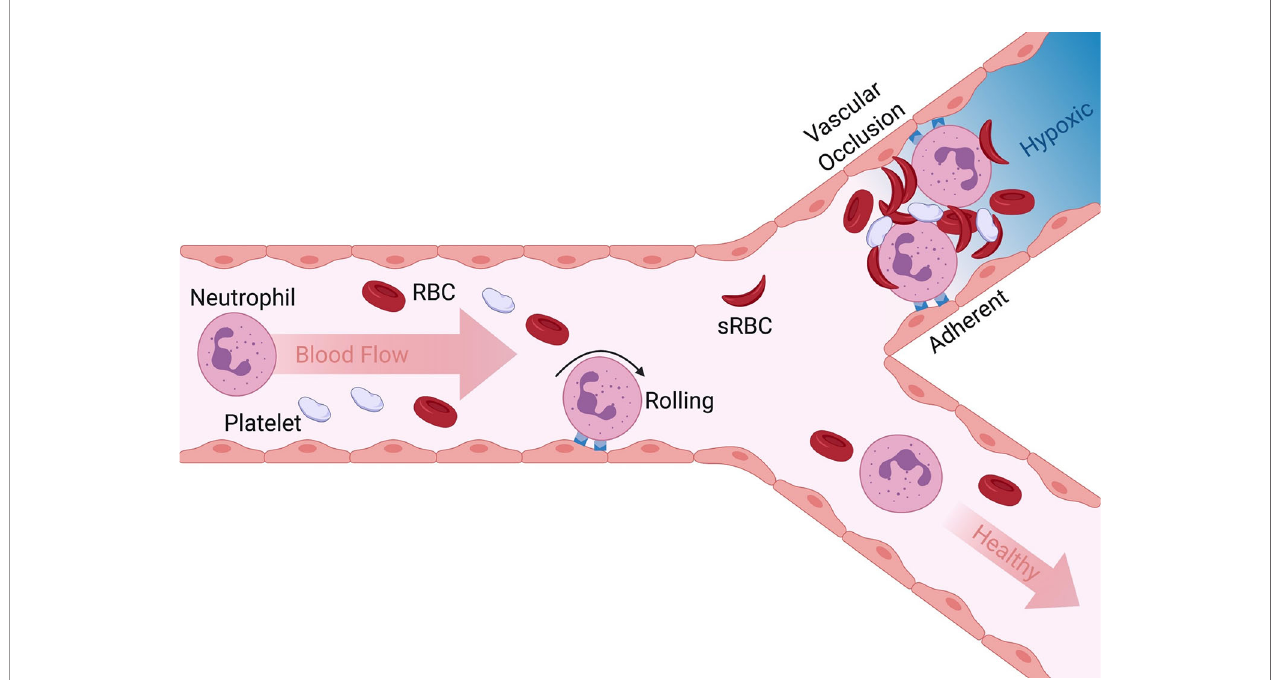
FIGURE 1 | Overview of initiation and progression of VOC in SCD. Neutrophil rolling to arrest on in fl amed endothelium is a normal innate immune response to tissue injury. Adherent neutrophils can also capture sickle red blood cells and platelets in post capillary venules leading to vascular occlusion (upper bifurcation). Dramatic reduction in blood fl ow and lack of oxygen results in hypoxia, episodic painful and often leads to organ failure. When inappropriate neutrophil activation and adhesion is absent and secondary capture of RBC and platelets limited, the vasculature remains perfused and healthy (lower